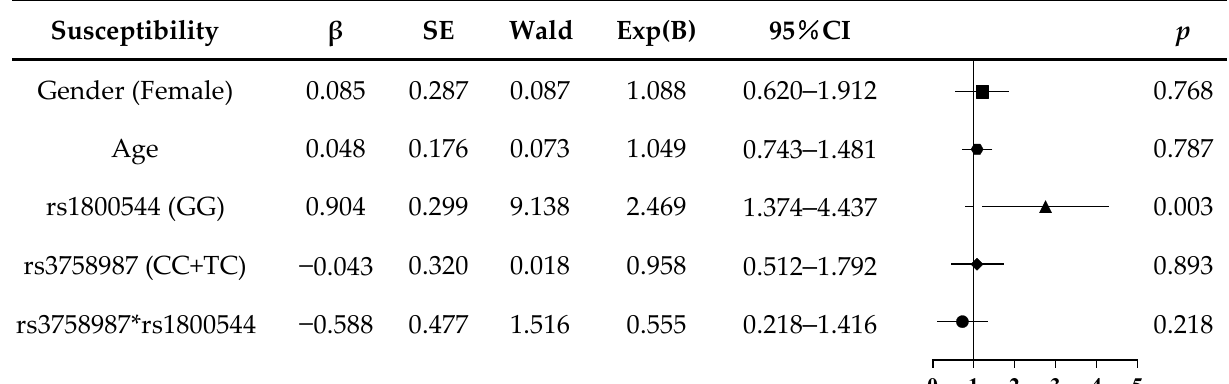
Figure 1. Logistic regression analysis of risk of motion sickness susceptibility in subjects.